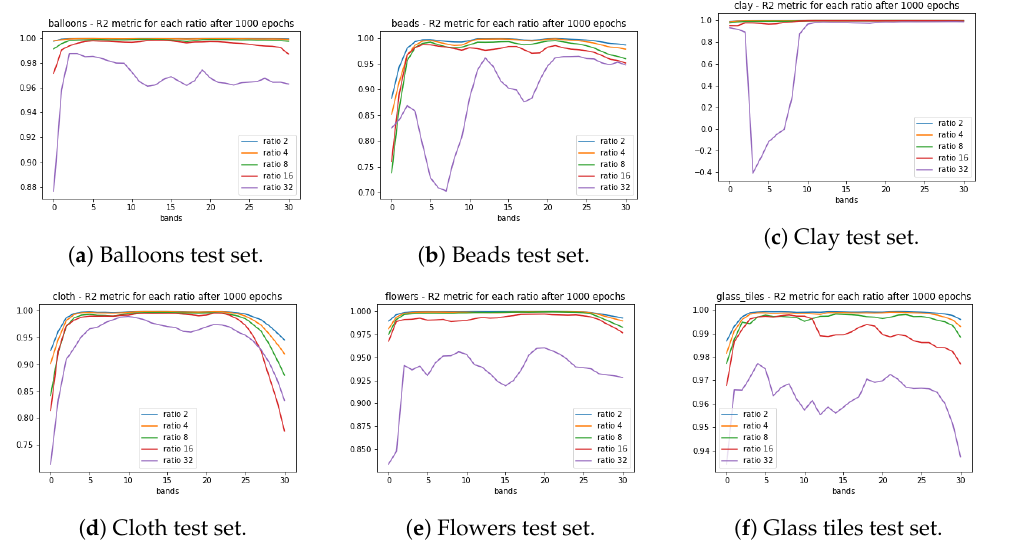
Figure 6. R 2 test set correlation metric for the CAVE dataset images chosen for the model validation. In each graph, the R 2 is computed for each of the 31